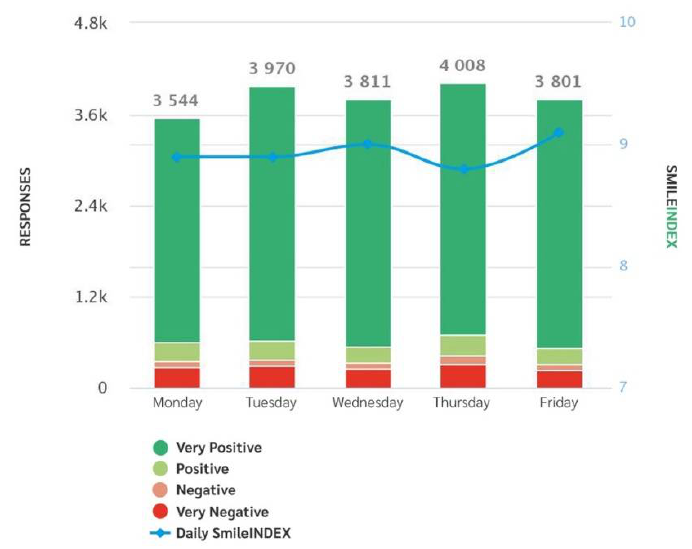
Figure 2. Trends by hour.